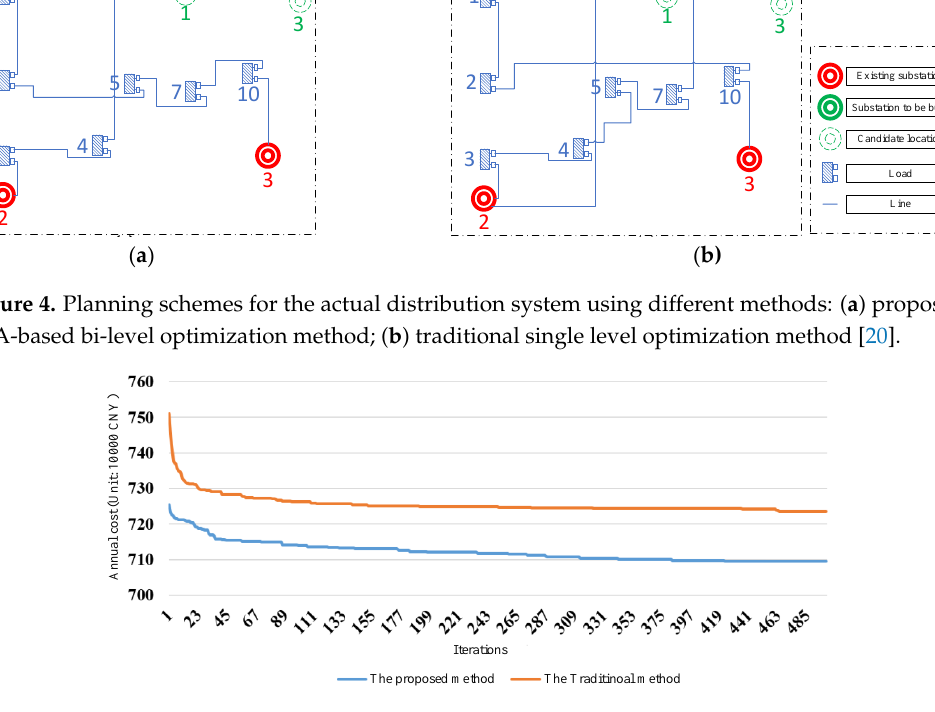
Figure 5. Optimized annual costs for each iteration in joint planning of substations and lines in distribution systems.